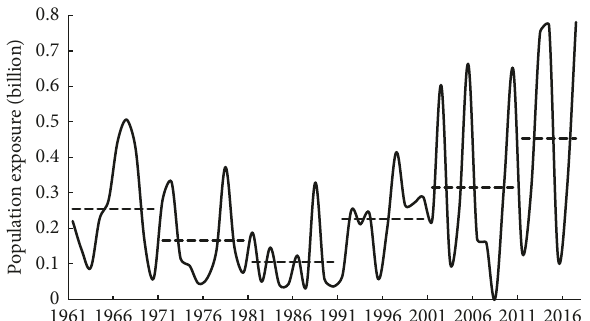
Figure 6: Population exposure to heatwave events on the North China Plain.